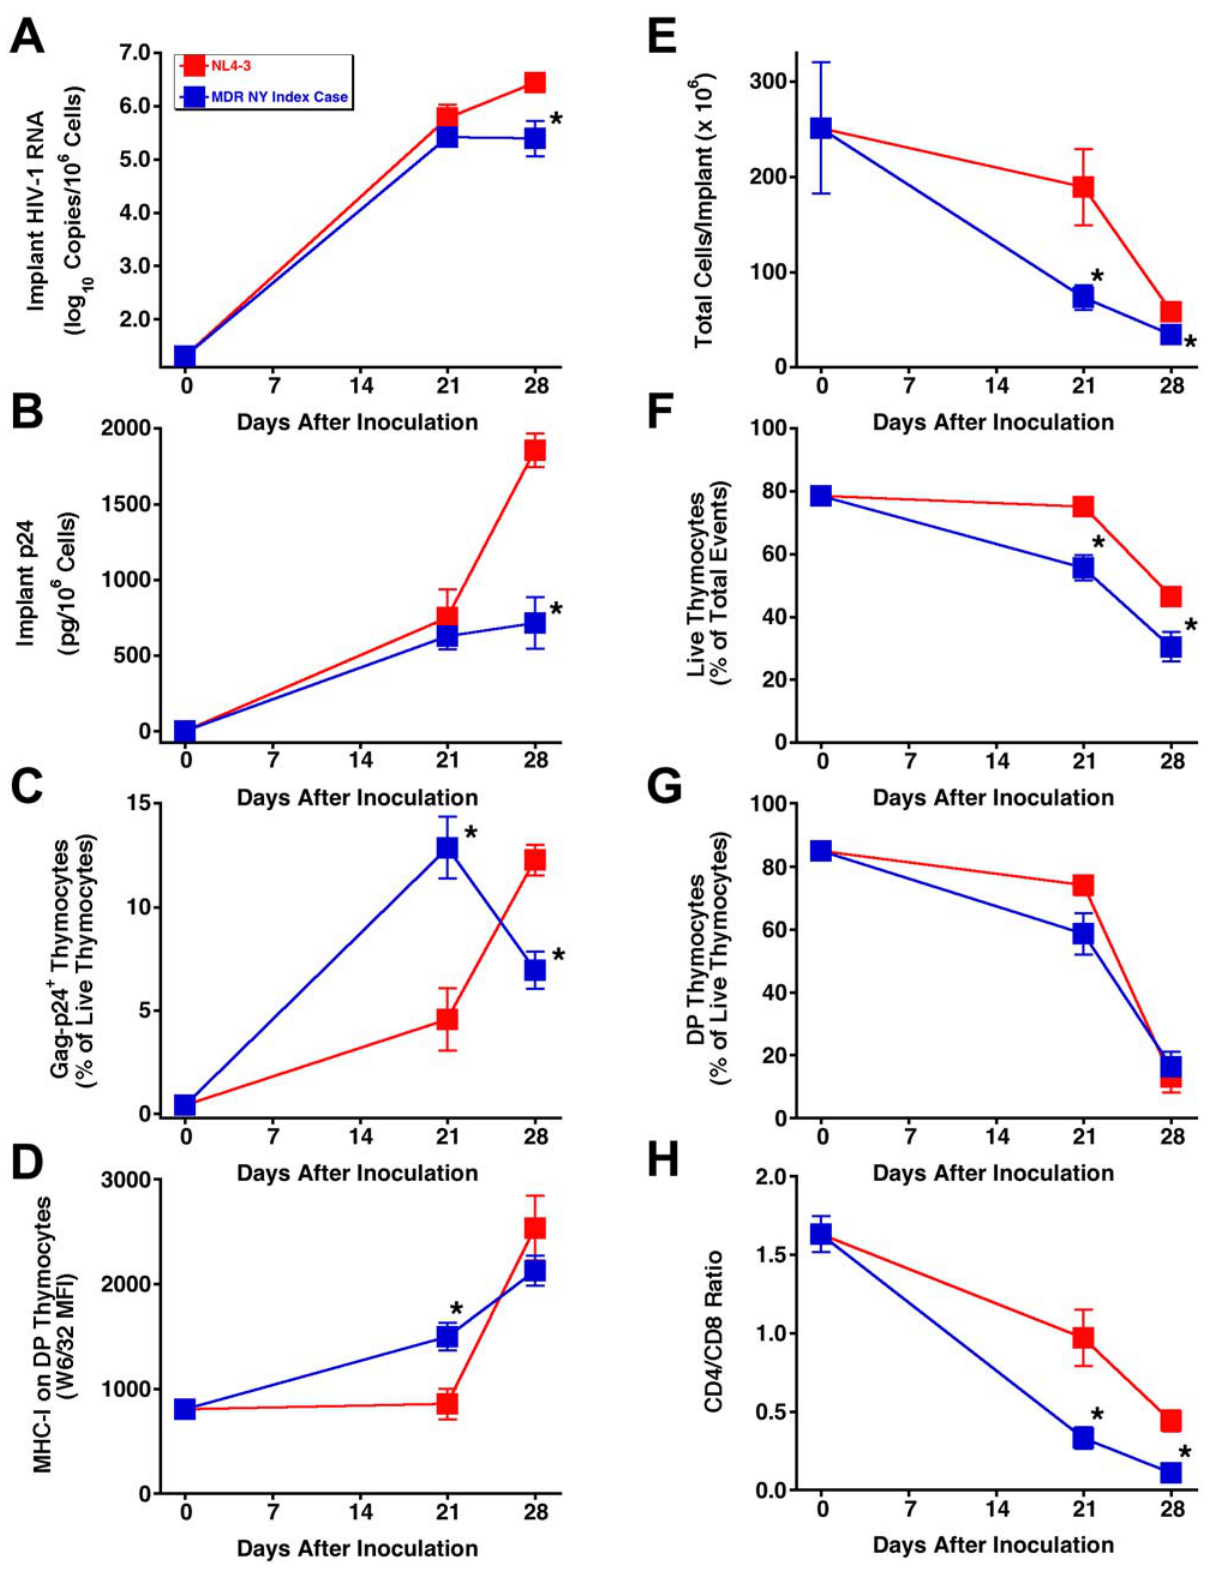
Figure 8. Multidrug-resistant (MDR) NY index case HIV-1 replicates and depletes thymocytes with kinetics comparable to HIV-1 NL4-3 in SCID- hu Thy/Liv mice. Viral replication assessed by determining HIV-1 RNA (A), p24 (B), Gag-p24 + thymocytes (C), and MHC-I expression on DP thymocytes (D). Thymocyte protection was assessed by total implant cellularity (E), thymocyte viability (F), percentage of DP thymocytes (G), and CD4/CD8 ratio (H) for NL4-3 versus MDR NY index case HIV-1-infected mice (means 6 SEM). *p # 0.05, compared with untreated mice for 7 mice per group.